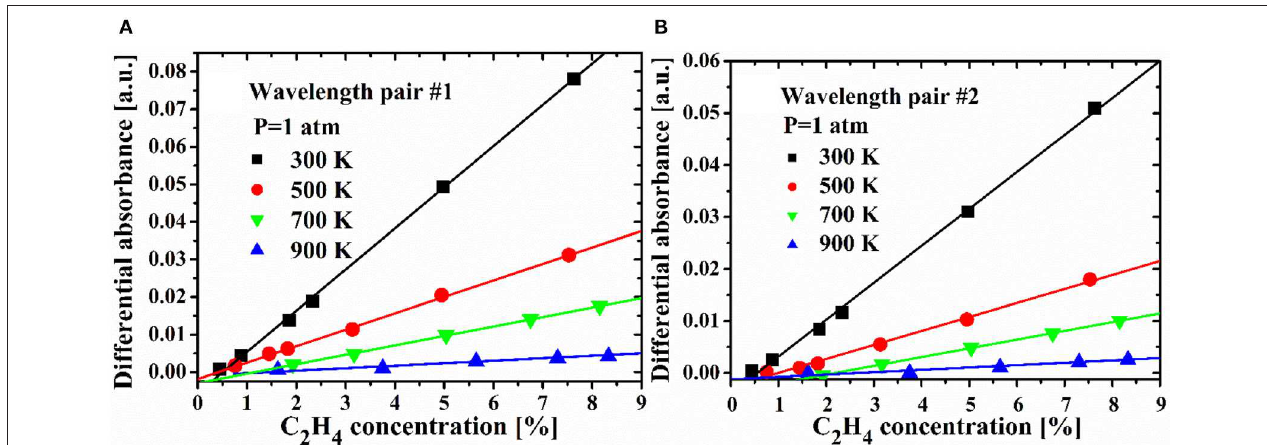
Frontiers in Physics |